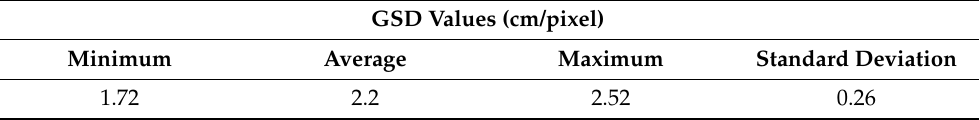
Table 3. GSD Values of the Photogrammetry